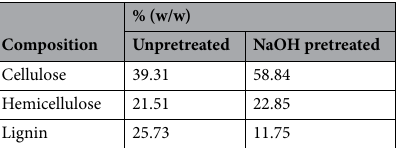
Table 2. The composition change of WS after NaOH pre-treatment.